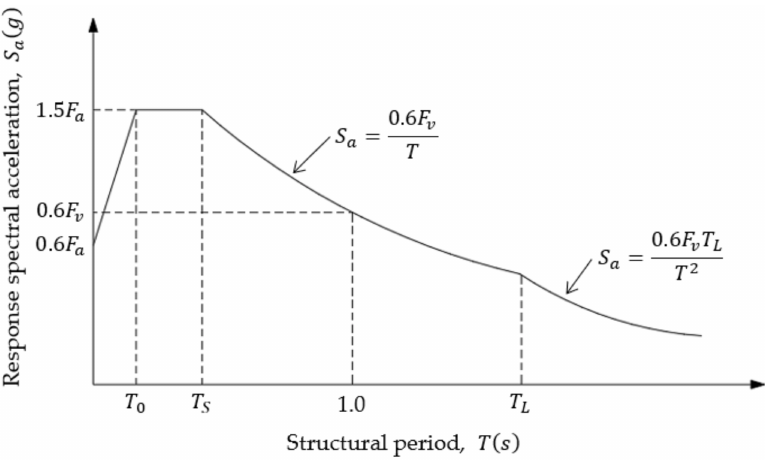
Figure 18. Lower limit of deterministic response spectrum for risk category III and